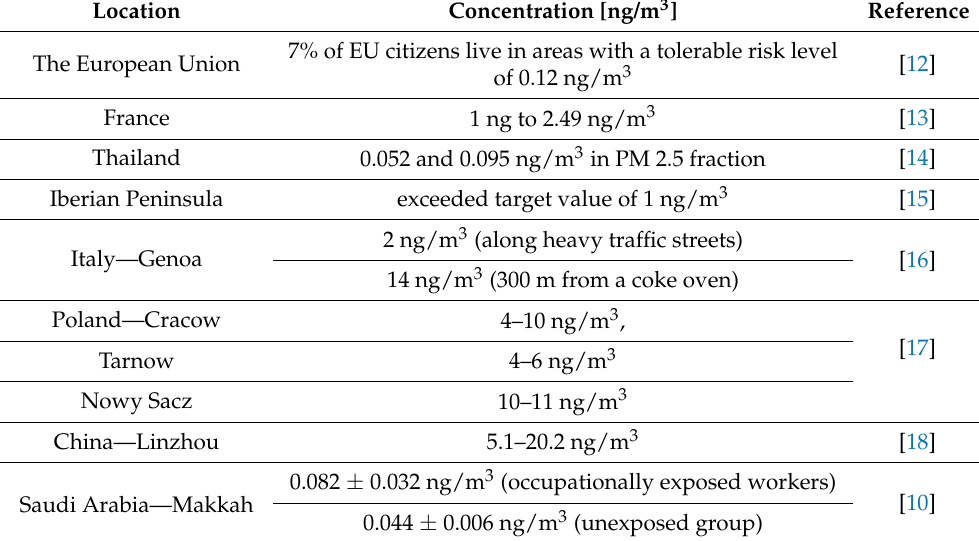
Table 1. B[ a ]P levels in outdoor